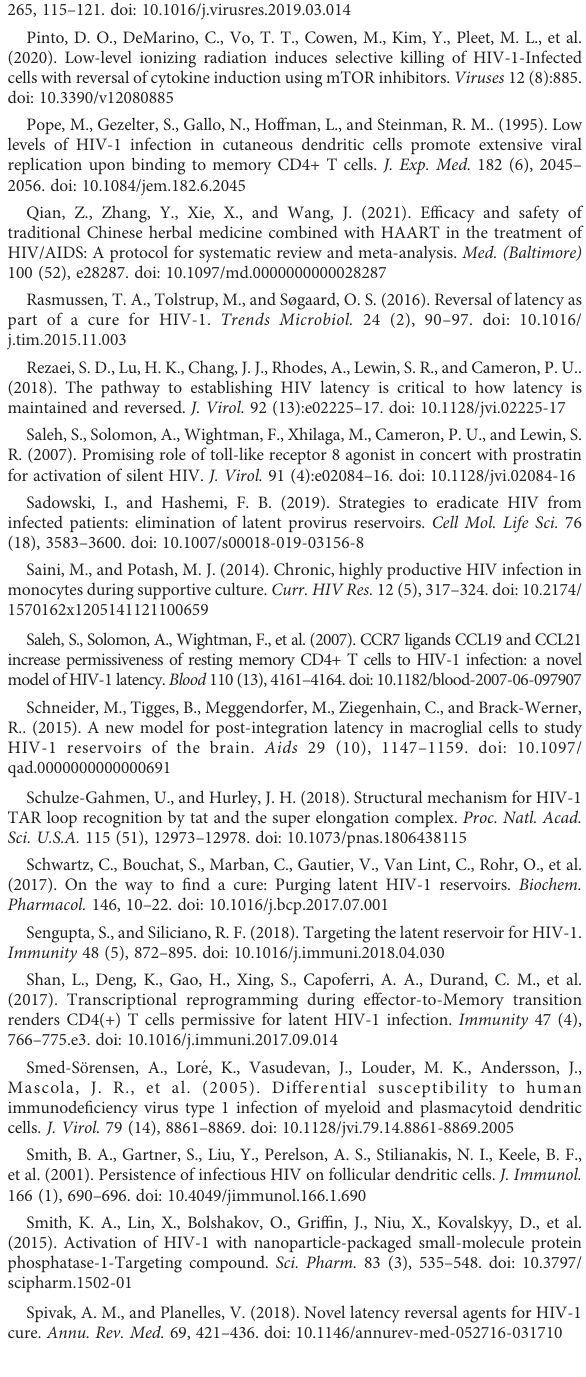
Tabler, C. O., Lucera, M. B., Haqqani, A. A., McDonald, D. J., Migueles, S. A., Connors, M., et al. (2014). CD4+ memory stem cells are infected by HIV-1 in a manner regulated in part by SAMHD1 expression. J. Virol. 88 (9), 4976 – 4986. doi: